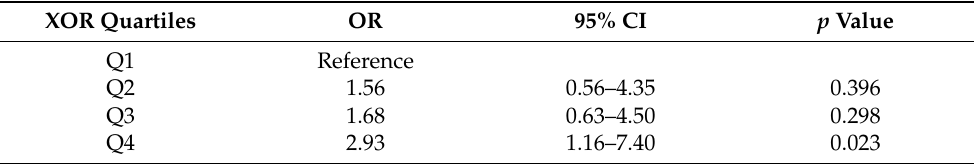
Table 6. Multivariate adjusted ORs for the high risk for CVD (FRS ≥ 15) by XOR quartiles.